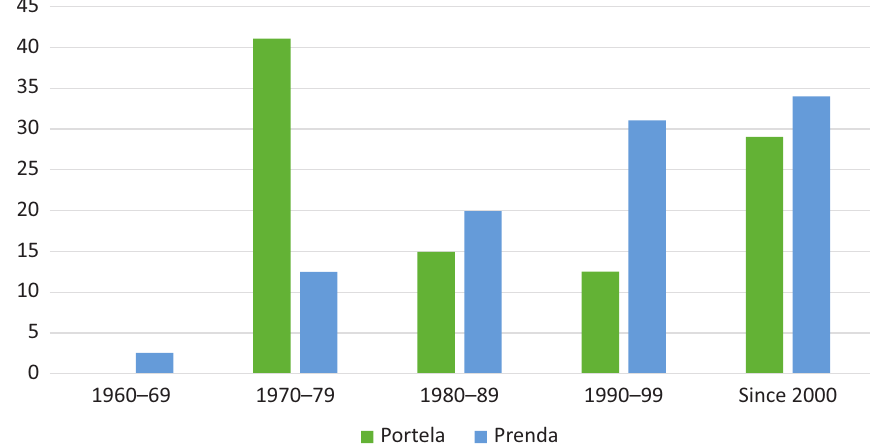
Figure 10. Time of settlement of current residents of Prenda and Portela by decade, in %. Work based on the Population Surveys of Neighbourhood Unit No. 1 of Prenda Neighbourhood (2015) and the Population of Portela Urbanisation (2014) by Dinâmia’Cet. Source: Guerra and Pereira (2018, p. 72).